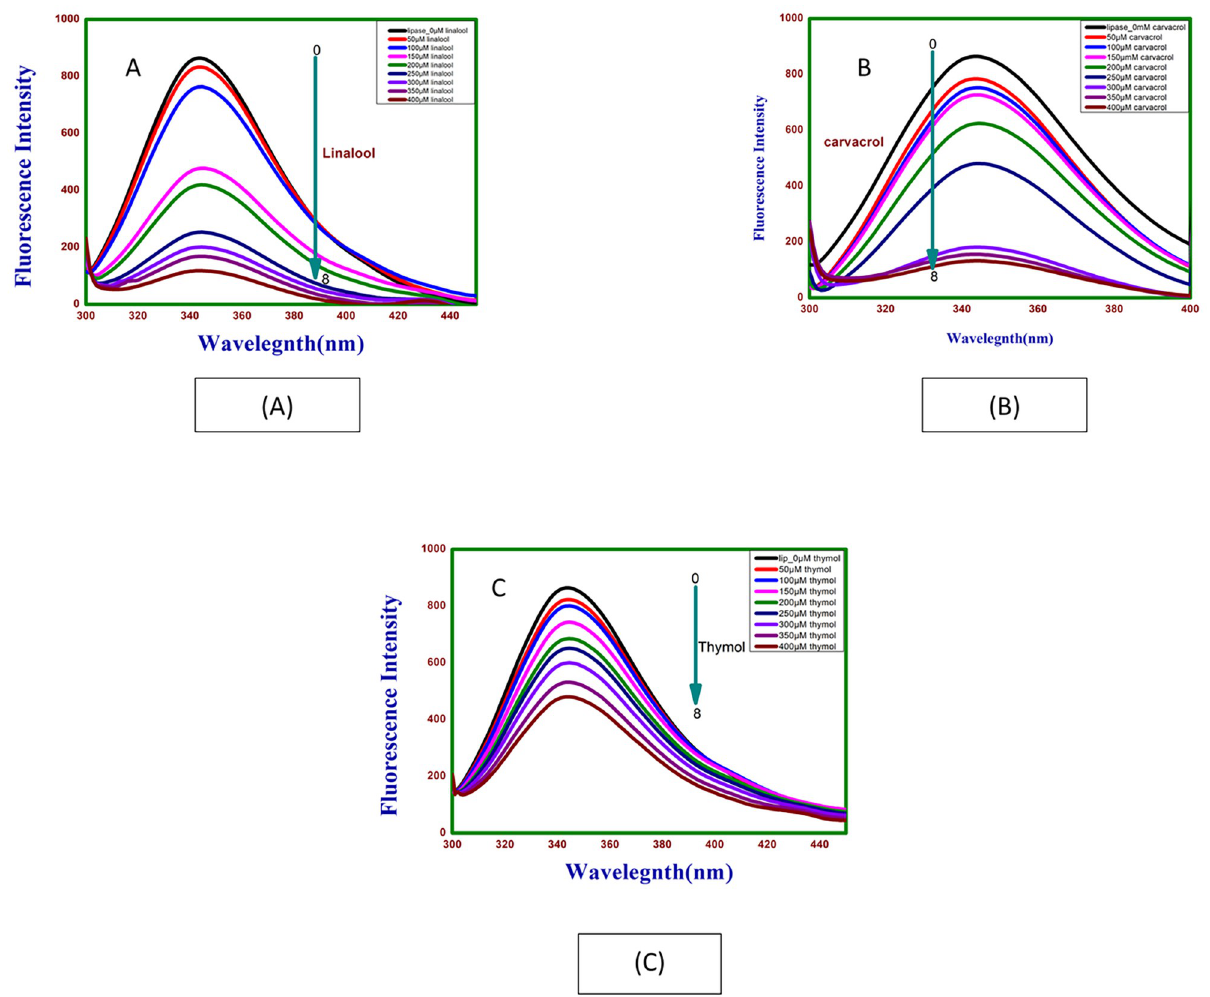
Fig 6. Emission spectra of lipase on (A) linalool, (B) carvacrol and (C) thymol at different concentrations.